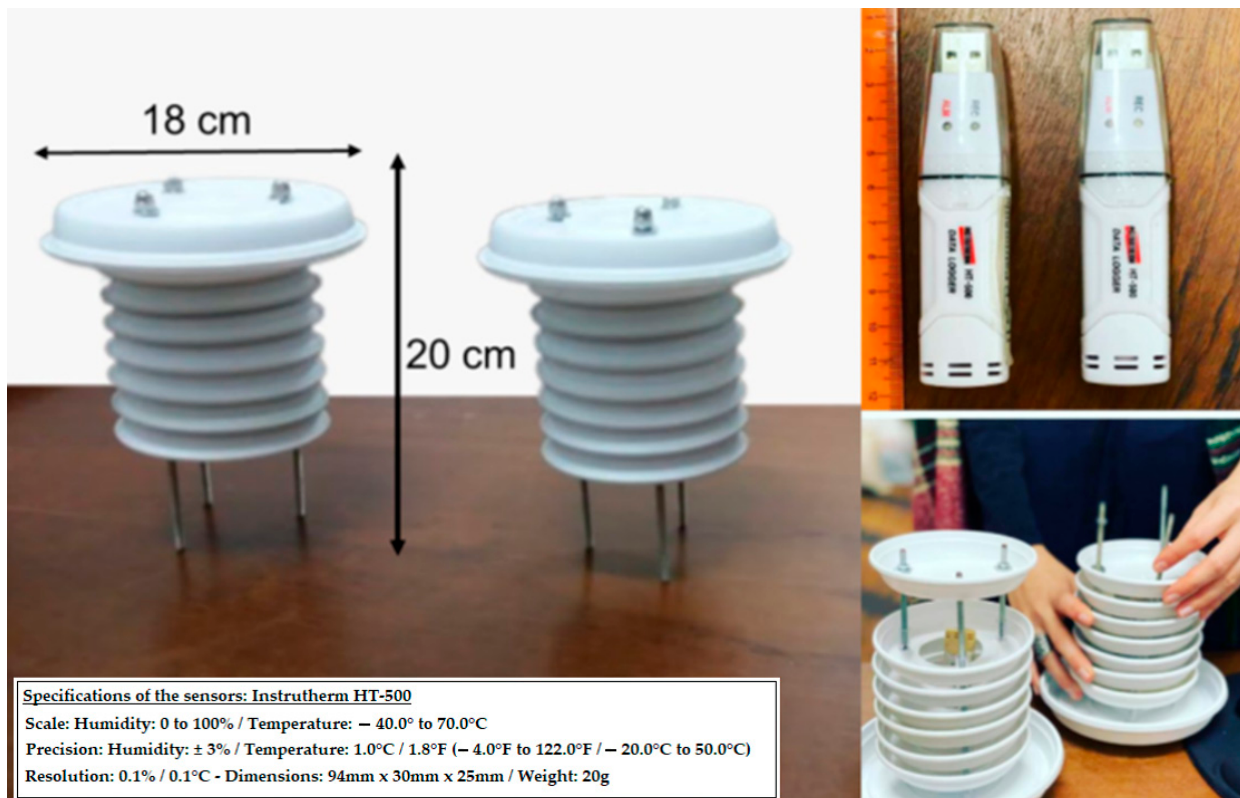
Figure 4. LCMS and HT 500 Instrutherm thermo-hygrometer. Source: the authors (2022).